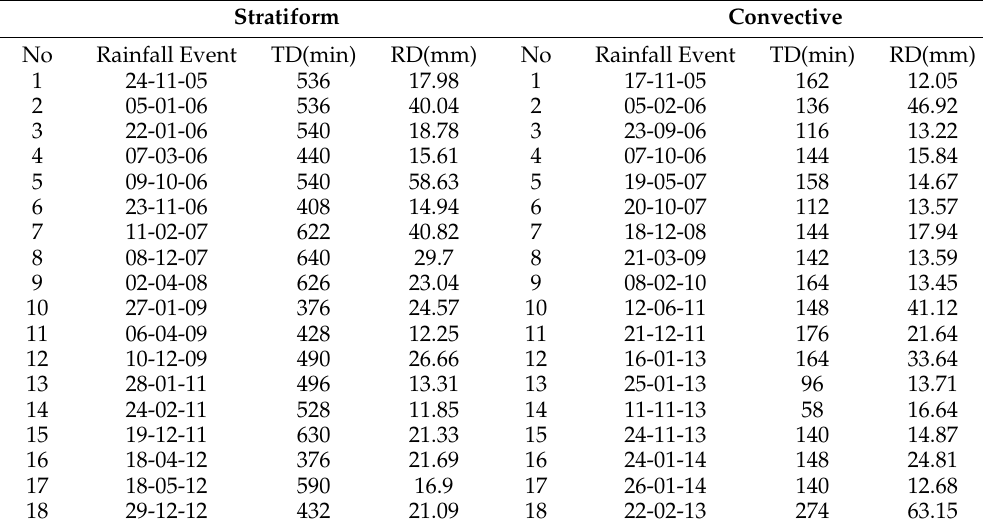
Table 1. Stratiform and convective storm